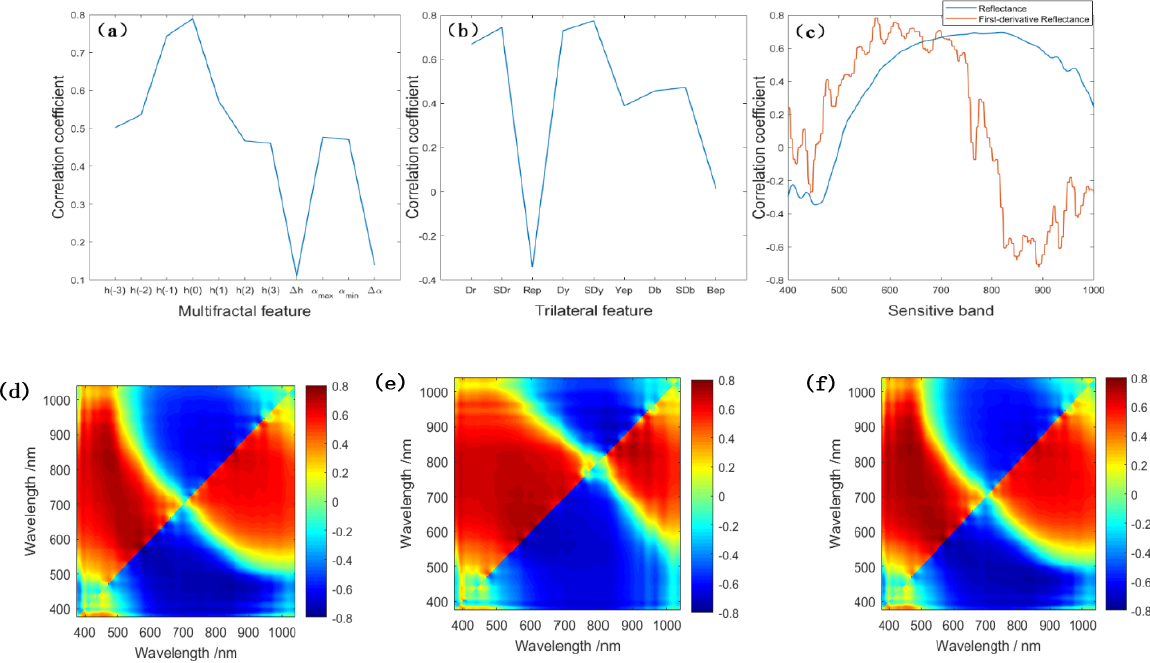
Figure 2. Correlation analysis between four types of parameters and the oleic acid content. ( a – c ) are the correlation coefficient of the oleic acid content with respect to the multifractal feature, trilateral feature, and sensitive band, respectively. ( d – f ) represent the correlation coefficient between the oleic acid content and three spectral indexes, namely the ratio spectral index (RSI), normalized spectral index (NDSI), and difference spectral index